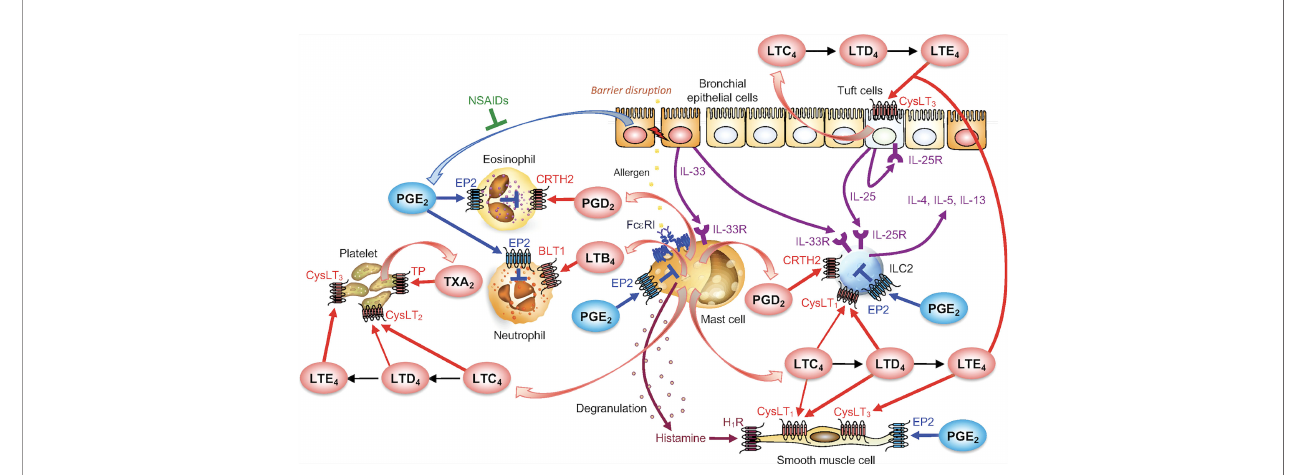
FIGURE 3 | The mast cell-driven eicosanoid network in asthma. PGD 2 and LTs produced by activated mast cells act on various cell types including leukocytes, platelets, bronchial epithelial cells and smooth muscle cells to promote allergic responses. PGE 2 , produced by various cells such as bronchial epithelial cells (but not mast cells), dampens allergic responses. NSAIDs (COX inhibitors) blocks PGE 2 production, thereby exacerbates asthma known as AERD. For details, please see the